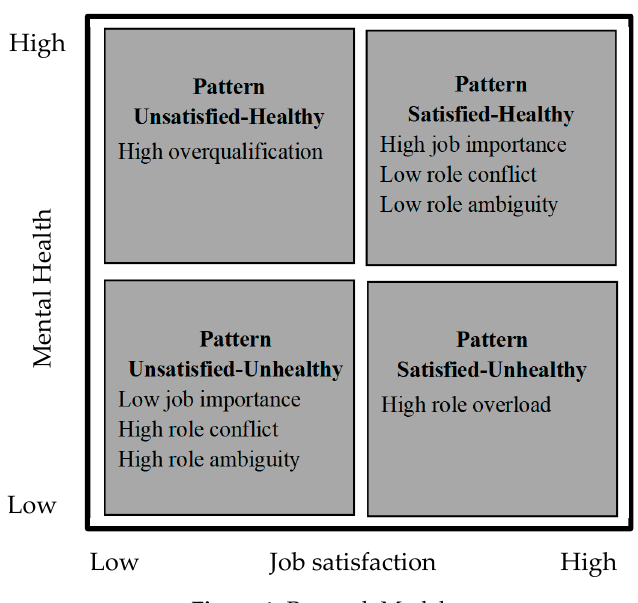
Figure 1. Research Model.